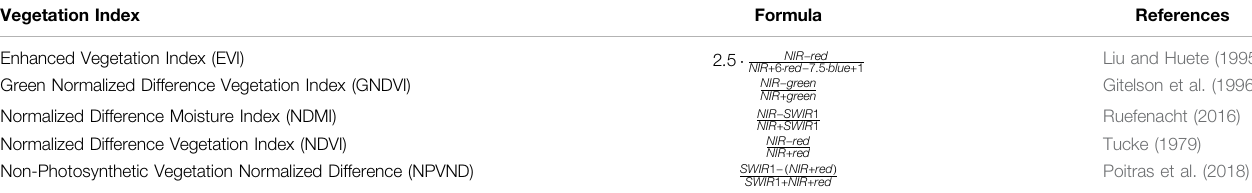
TABLE 2 | Summary of vegetation indices using blue, green, red, near infrared, and shortwave infrared spectral bands of Landsat 8 sensors. Vegetation Index